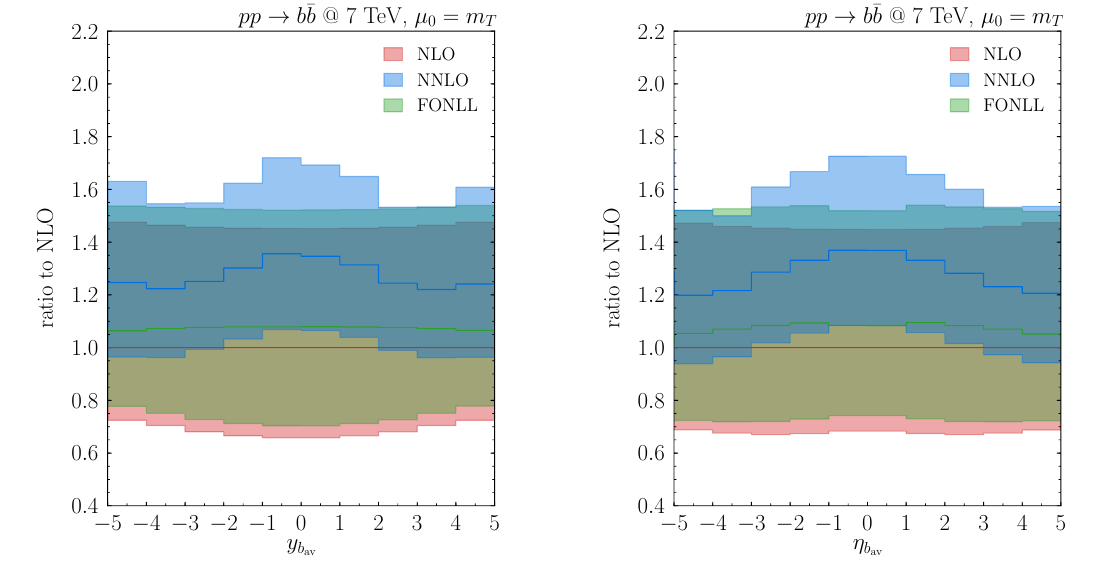
Figure 13 . Comparison between NLO, FONLL and NNLO predictions for the rapidity distribution d(cid:27)=dy b (left) and pseudorapidity distribution d(cid:27)=d(cid:17) b av ( p s = 7 TeV). The three results with their scale variations are normalised to the NLO prediction at central scale (cid:22) 0 = m T